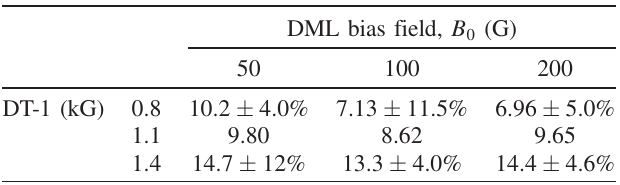
TABLE VII. Average rms variation over flattop